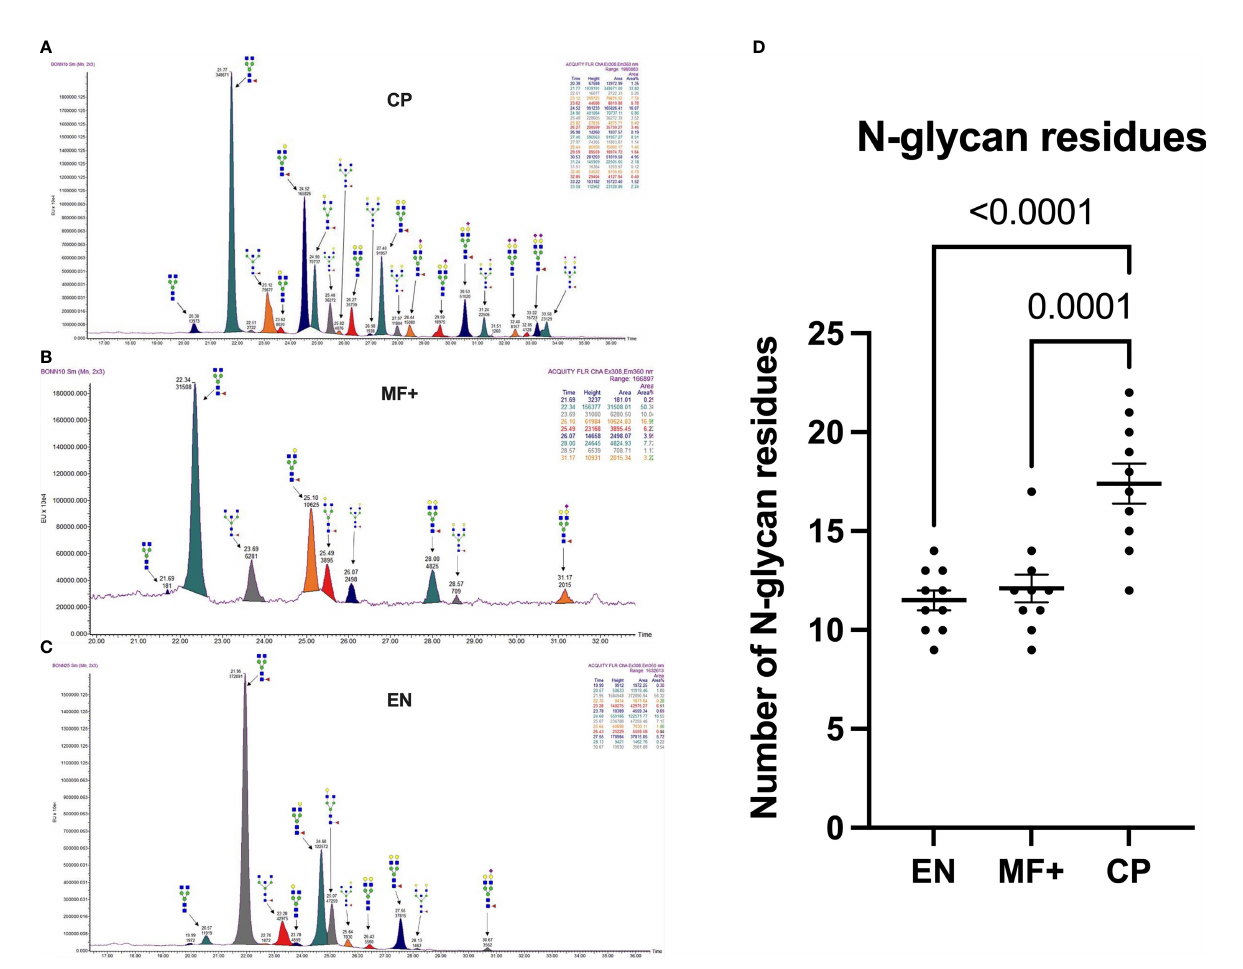
FIGURE 3 | Higher IgG-Glycan heterogeneity in CP patients. (A – C) Representative electropherograms from a CP (A) , MF+ (B) , and EN (C) indicating all structures present in the Fc region of IgG. (D) Relative abundance of IgG molecules carrying different glycan residues in total IgG puri fi ed from EN, MF+, and CP patients. Dots represent individual donors. Bars represent means ± SEM. The indicated p-values refer to the signi fi cance level among all groups according to Kruskal-Wallis test. Indicated p values re fl ect the level of differences after Dunn ’ s multiple comparisons test. Signi fi cance is accepted when P <